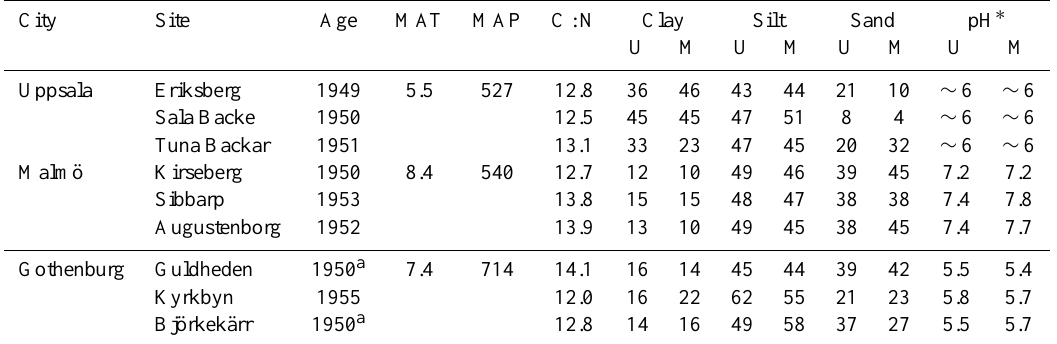
Table 1. Site characterisation with year of establishment; mean annual temperature [MAT, ◦ C] and mean annual precipitation [MAP, mm] (1961–1990); and clay, silt, and sand content [%] as well as soil pH for utility lawns (U) and meadow-like lawns (M) for all three Swedish cities